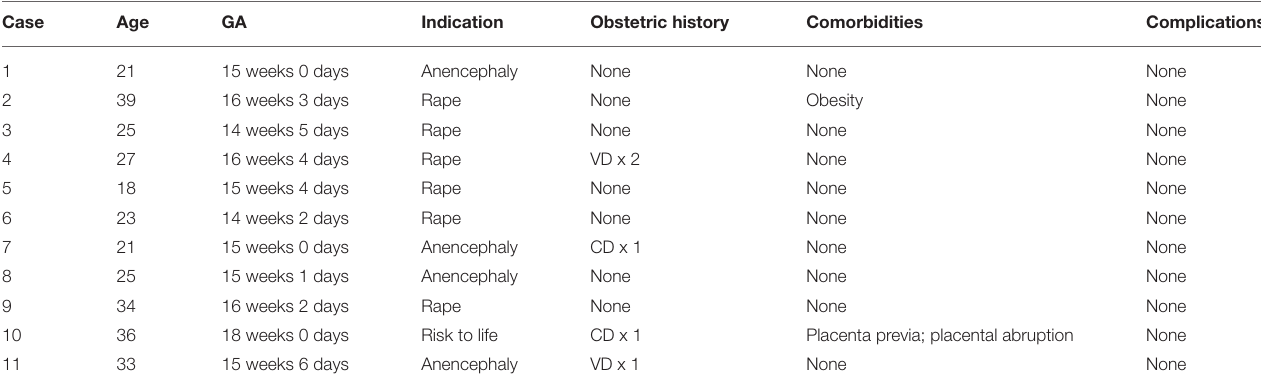
TABLE 2 | Clinical characteristics of D&E cases performed independently by newly trained providers after focused clinical training.